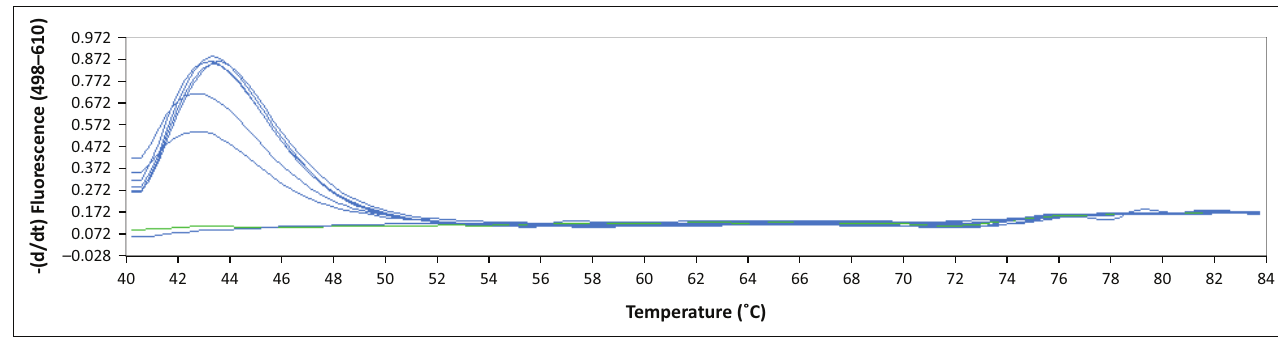
peak B (65.3°C). 2